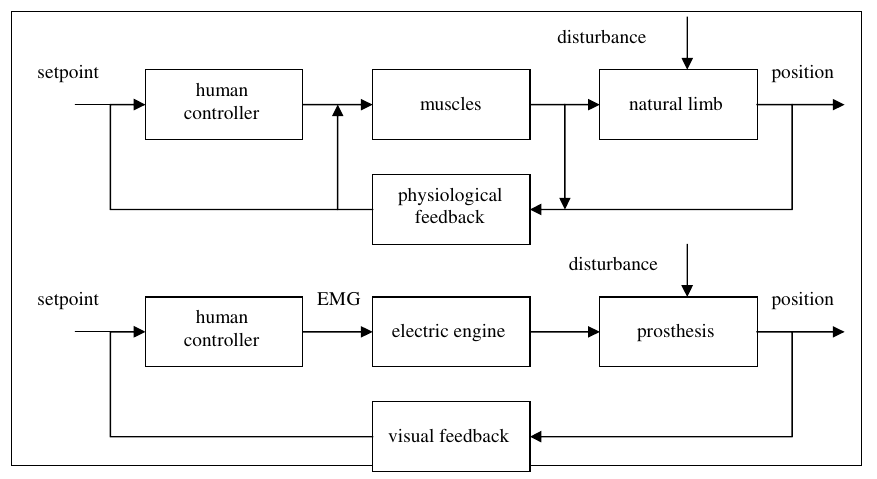
Fig. 2. Comparison of the controller of a natural limb (upper) and of EMG prosthesis